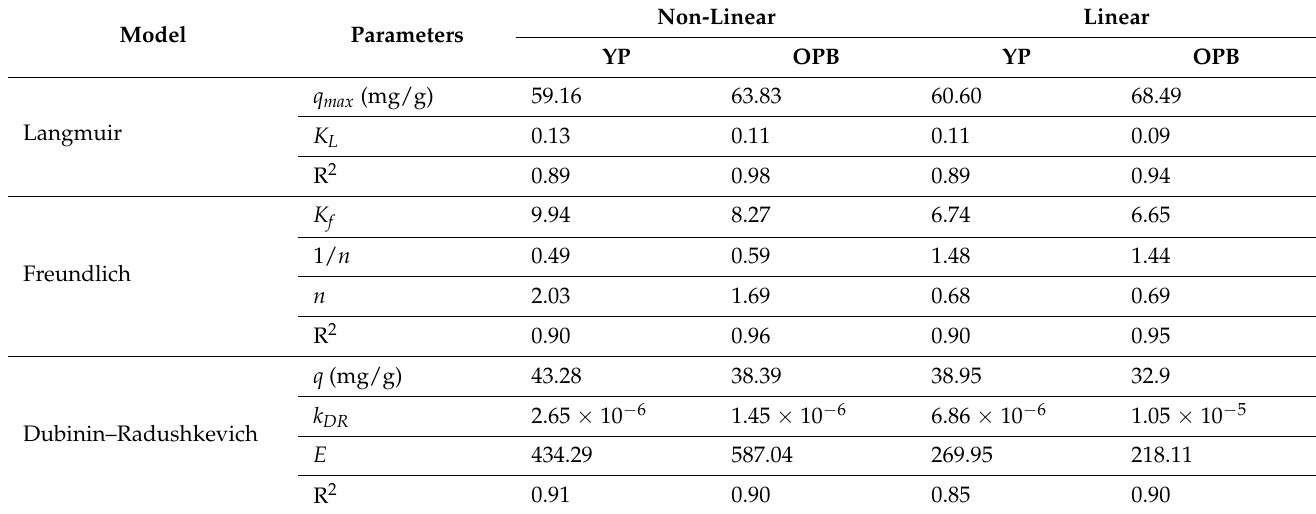
Table 6. Adjustment parameters of hexavalent chromium adsorption isotherms on YP and OPB. Model 头外居左 Parameters